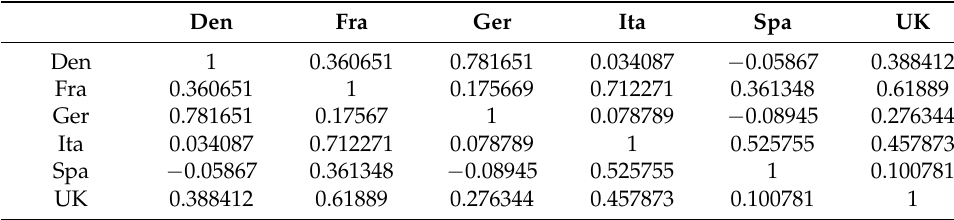
Figure 3. The daily average price ( € ) series with the mean values and the standard deviation. The evolution of average prices over seven years shows there is no trend in any of the series. The graphs for some countries show strong similarities, e.g., Denmark and Germany. Furthermore, Italy and France, especially from 2016 onwards. The degree of similarity can be measured by the correlation matrix or by the correlation matrix of the differenced series (Table 1). The correlation between Denmark and Germany is high for both average and incremental data. It is also high for the pairs (Denmark, UK), (France, Italy) and (France, UK). Table 1. The correlation matrix of the differenced series.